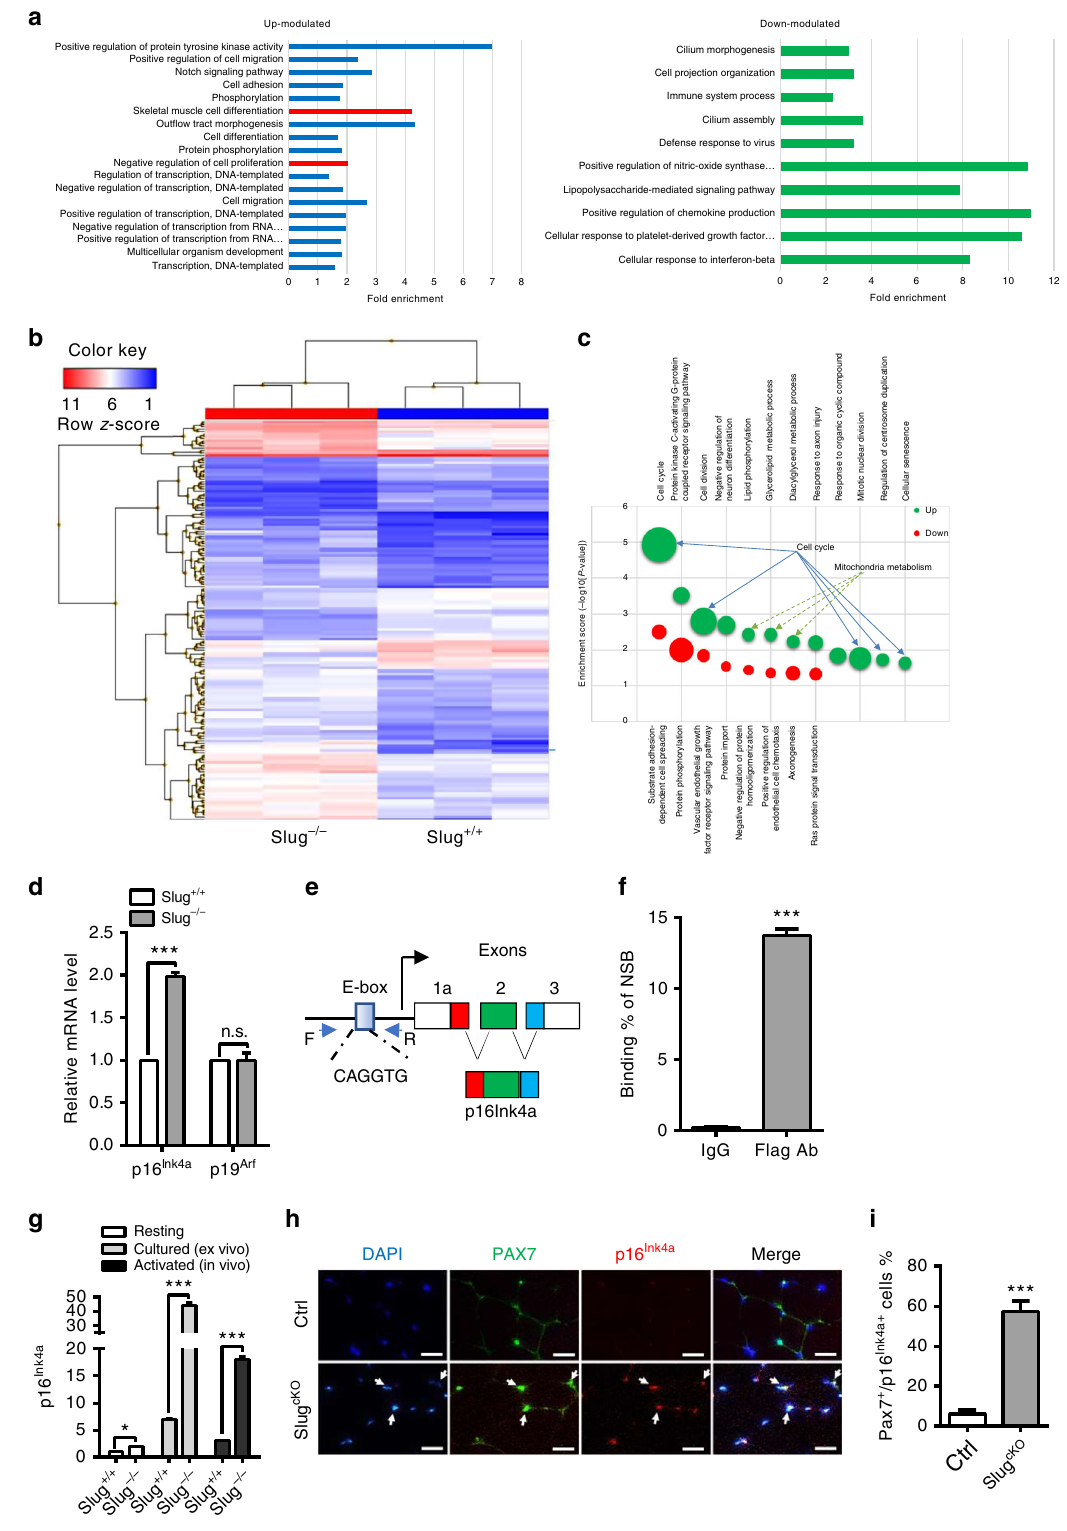
Population doubling level (PDL) is an intrinsic measurement of the age of the particular culture of a cell line. In culture, an untransformed cell line has a fi nite life span expressed in the number of cumulative population doublings that can be achieved. To assess the accelerated senescence in Slug -de fi cient SCs